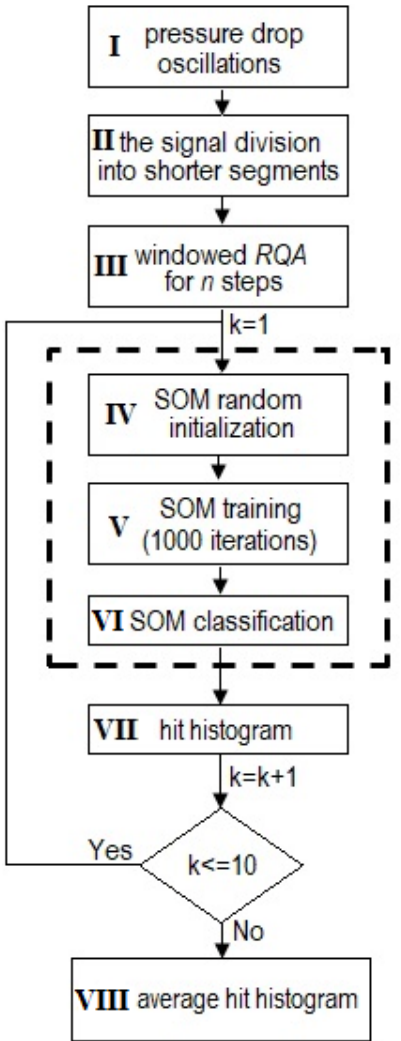
Figure 6. Flowchart of the pressure drop oscillation analysis using the recurrence quantification analysis ( RQA) and a self-organizing map ( SOM) network.